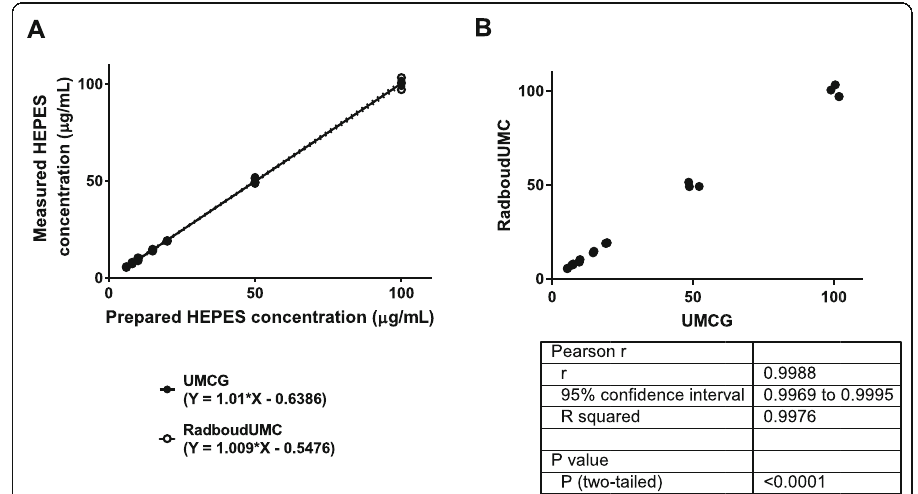
Fig. 5 a Calibration curves obtained with solutions prepared in two different institutes. b Comparison of the 2 calibration